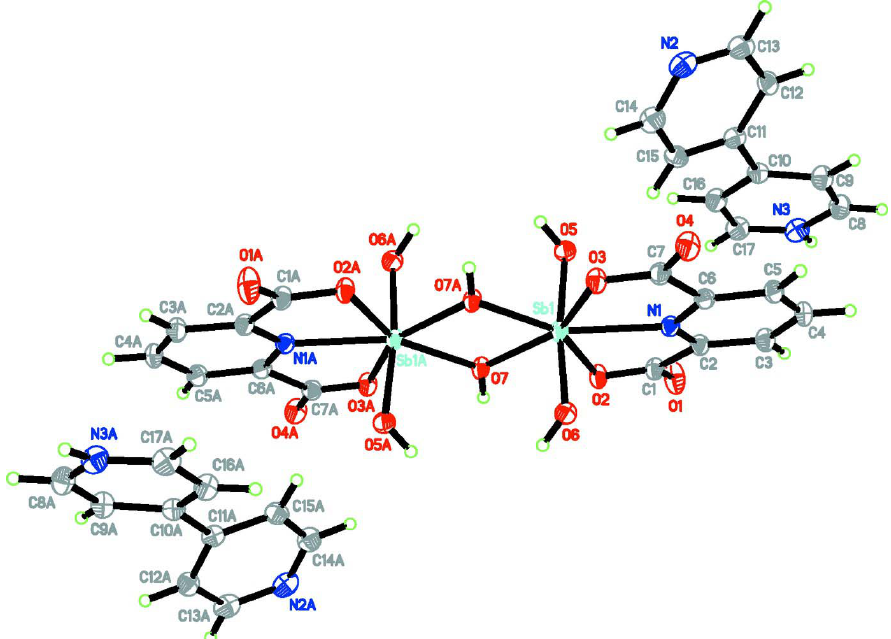
Figure 1 A view of the molecular structure of the title compound, showing the atom labelling scheme and displacement ellipsoids drawn at the 50% probability level. Uncoordinated water molecules are omitted for clarity. Atoms marked with A are related by the symmetry code (- x , - y , - z